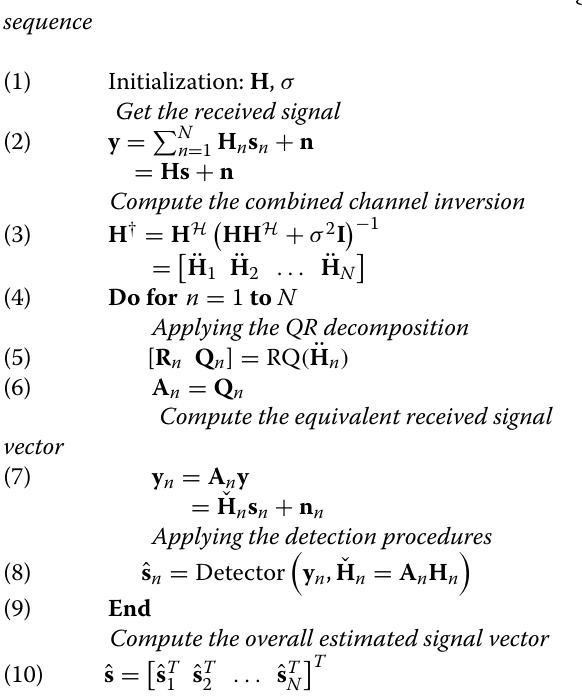
Algorithm 1 : The DSD algorithm Channel and noise variance estimated with